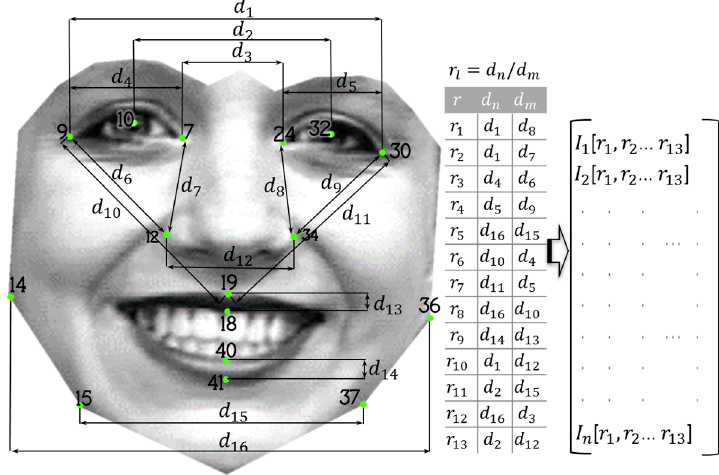
Figure 10. Ratios between face distances considered for Experiment 2.